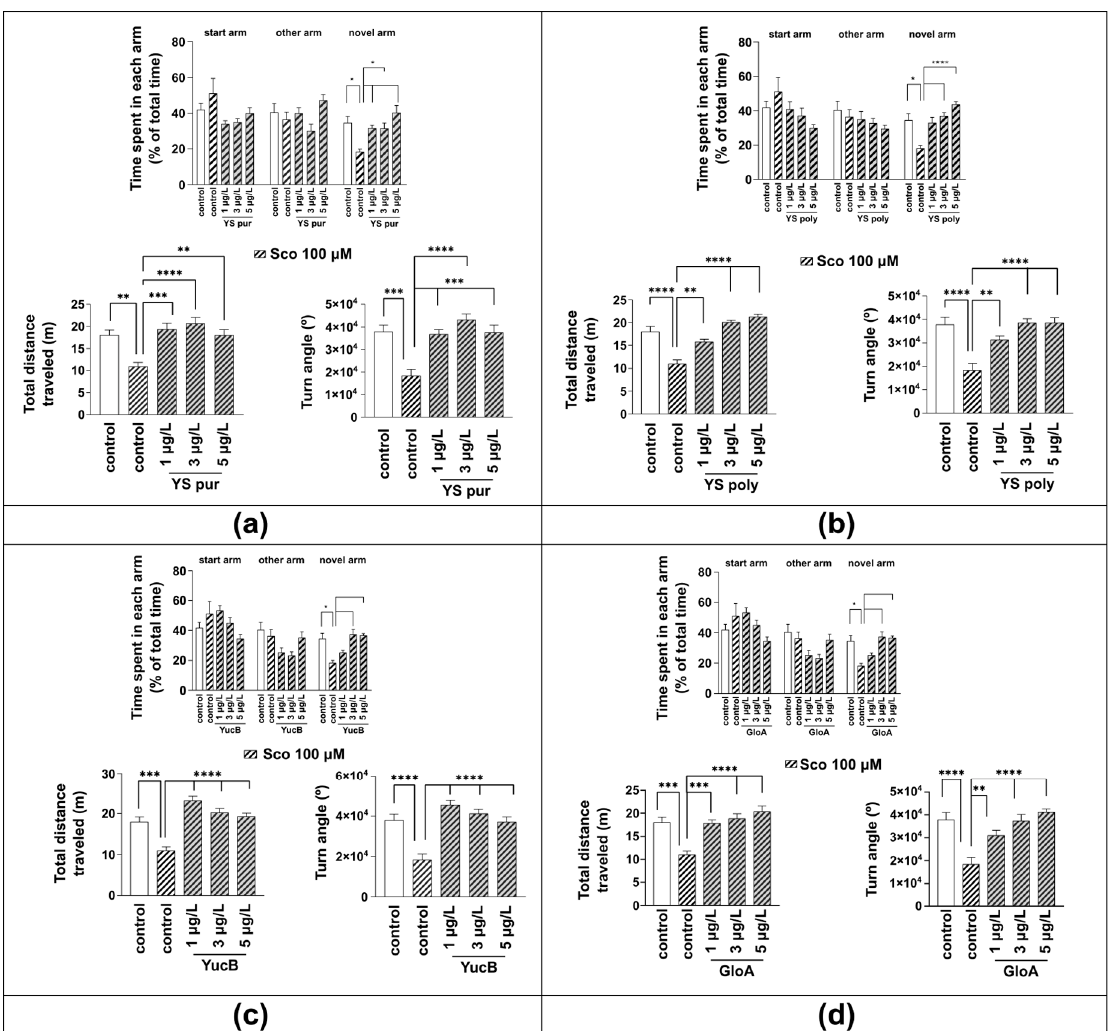
Figure 3. The effects of YS preparations (1, 3 and 5 µ g/L) on memory and locomotor activity in scopolamine (Sco)-treated zebrafish in the Y-maze test. Memory: time spent in each arm (start, other and novel arm); Locomotion: total distance traveled and Turn angle of zebrafish in the tank in the control—untreated group; group treated with scopolamine (Sco 100 µ M); groups treated with Sco (100 µ M) and ( a ) YS pur—purified fraction; ( b ) YS poly—polymeric fraction; ( c ) YuB—yuccaol B; and ( d ) GloA—gloriosaol A. Values are means ± S.E.M. ( n = 10). For Tukey’s post hoc analyses * p < 0.05, ** p < 0.01, *** p < 0.001, **** p <